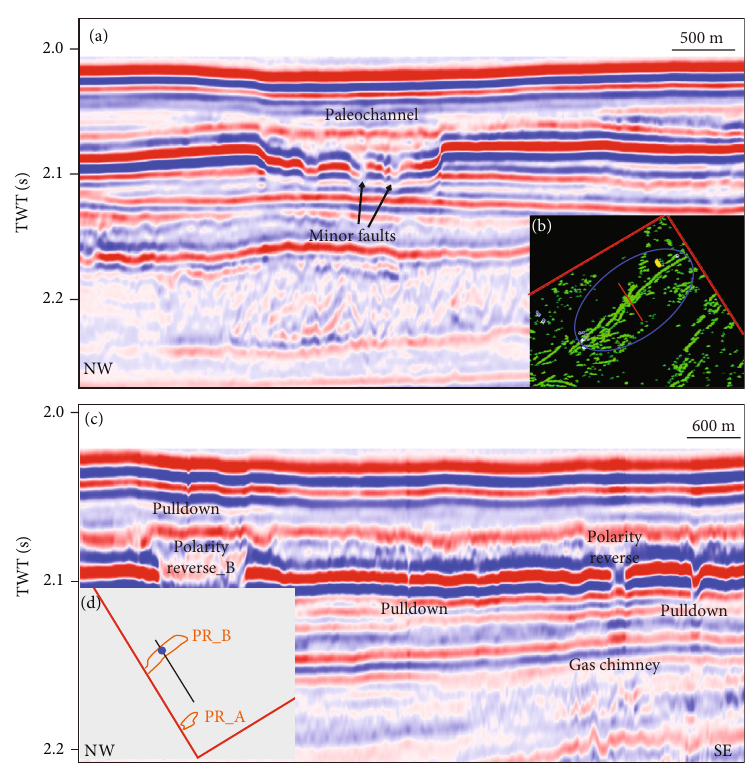
Figure 6: (a, c) Seismic sections and (b, d) distributions of the minor faults and pulldowns in the study area. The red line in panel (b) represents the seismic section shown in panel (a). The green points and blue oval indicate the minor faults and paleochannel, respectively. The black line in panel (d) represents the seismic section shown in panel (c), and the orange areas indicate the polarity reverse zones in the study area. The blue point indicates the location of the pulldown above the